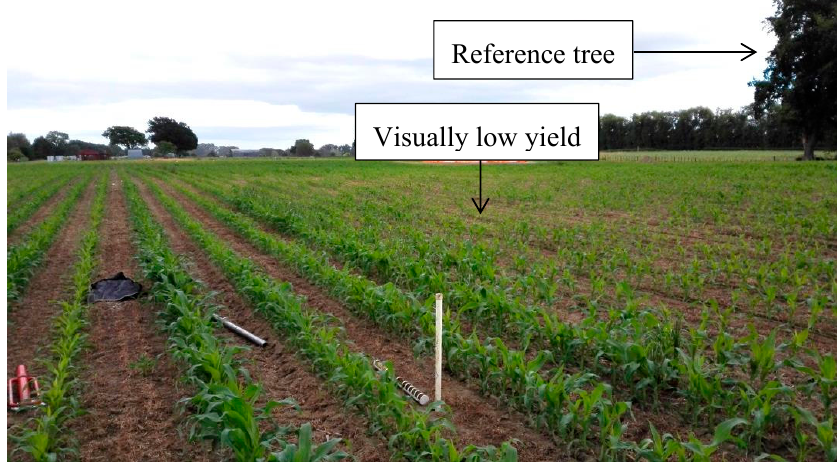
Figure 13. Site 1 (the photographer was standing facing South, with the tree on the right-hand side as an approximate reference of the location; visually low yield in the middle centre and middle right of the photo matched with the small rise in